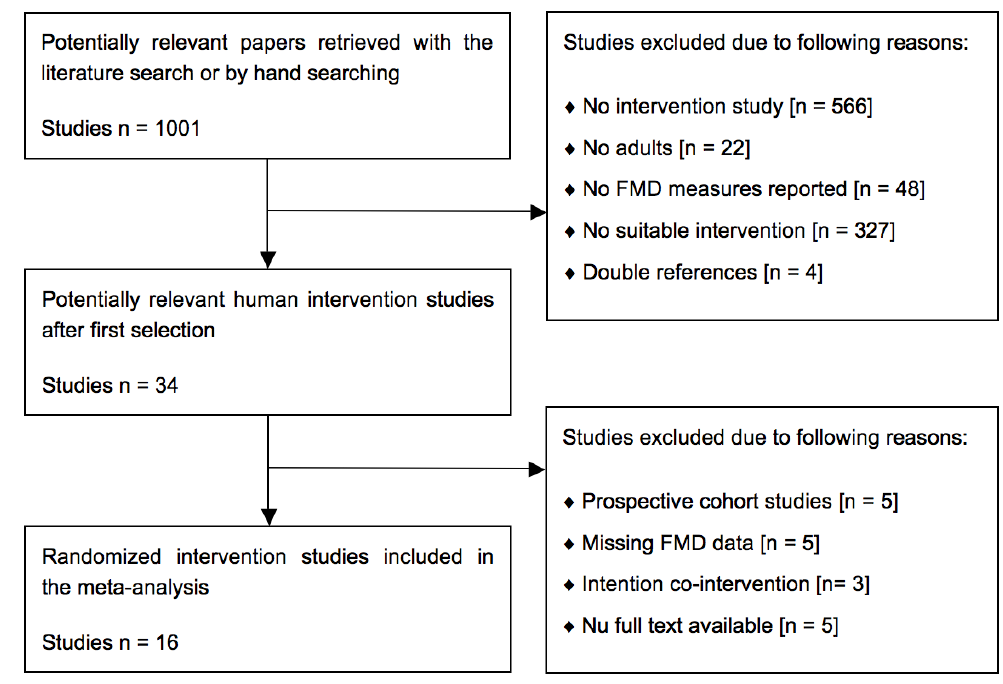
Figure 1. Flow diagram showing the study selection procedure of human intervention studies for the meta-analysis of fat-soluble vitamin supplements and endothelial function as measured by flow-mediated vasodilation (FMD), with the specification of